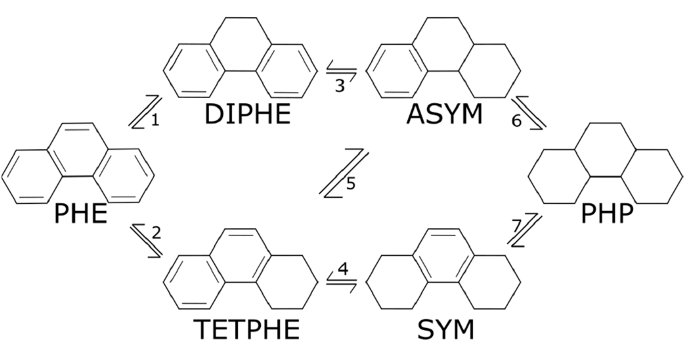
Figure 1. Reaction network for the hydrogenation of phenanthrene (PHE) and its products: 9,10-dihydrophenanthrene (DIPHE), 1,2,3,4-tetrahydrophenanthrene (TETPHE), 1,2,3,4,4a,9,10,10a- octahydrophenanthrene (ASYM), 1,2,3,4,5,6,7,8-octahydrophenanthrene (SYM), and perhydrophenan- threne (PHP).